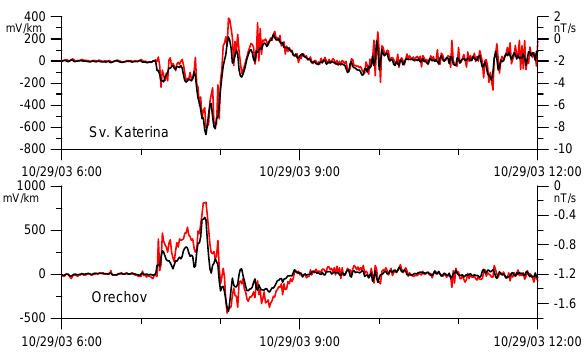
Fig. 6. Fit between the measured P/S voltage (red) and the com- puted geoelectric field (black) for the most disturbed period of 29 October 2003.